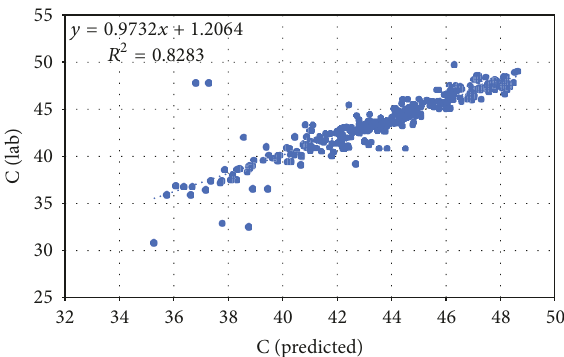
Figure 5: Linear regression relationship between laboratory refer- encemethodsandNIRS-predictedvaluesforC( 𝑅 2 = 0.83 )ofwinter and spring canola from 2011 on a dry weight basis.